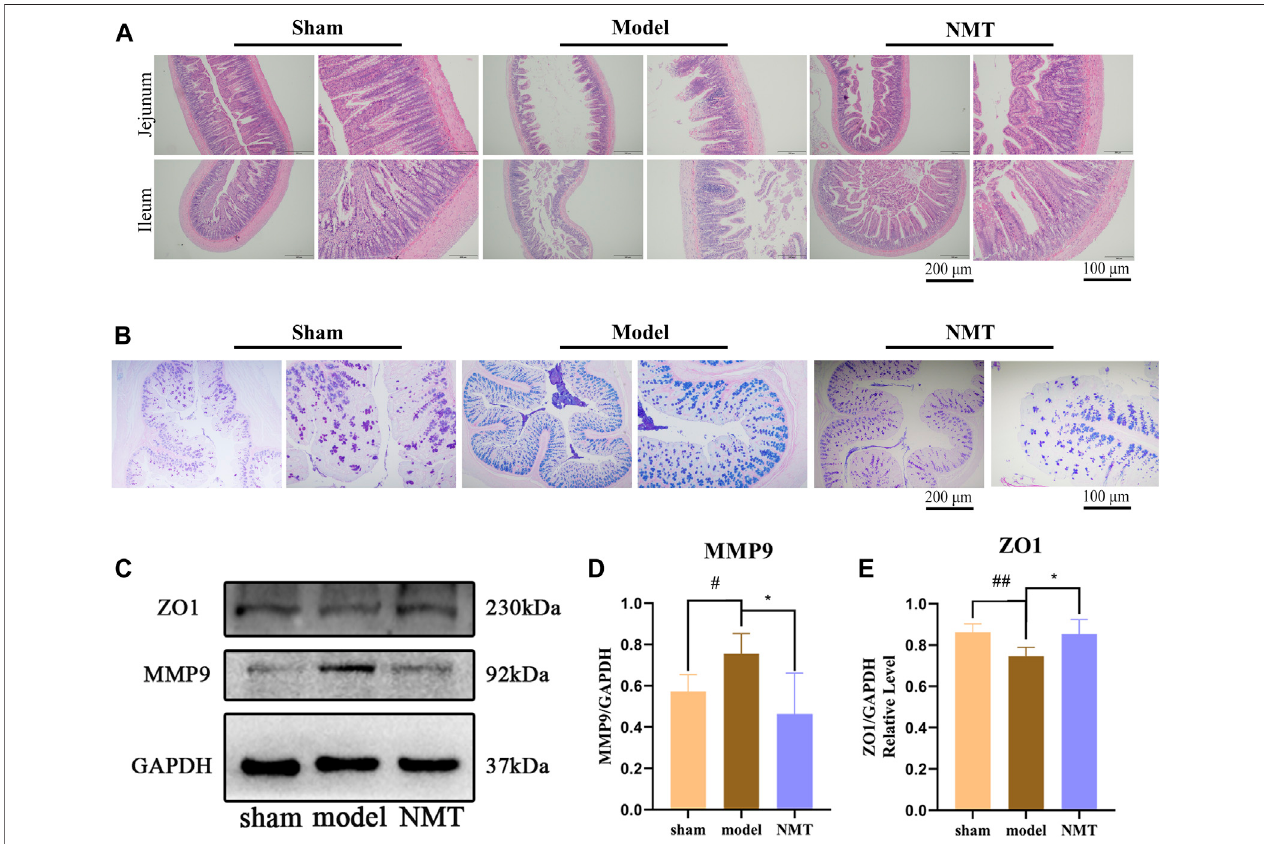
FIGURE 2 | NMT reversed the Damage of the intestinal barrier. (A) H&E Staining of intestinal tissue (scale bar (cid:1) 200 and 100 μ m n (cid:1) 4). (B) AB-APS Staining of intestinal tissue (scale bar (cid:1) 200 and 100 μ m n (cid:1) 3). Goblet cells are purplish red. (C) Representative Western blot bands of different groups and (D,E) quantitative analyses of endogenous ZO1 and MMP9 in colon of different groups. ( n ≥ 3). # p < 0.05, ## p < 0.01 compared with sham group; * p < 0.05, compared with the model group. Error bars represent mean ±